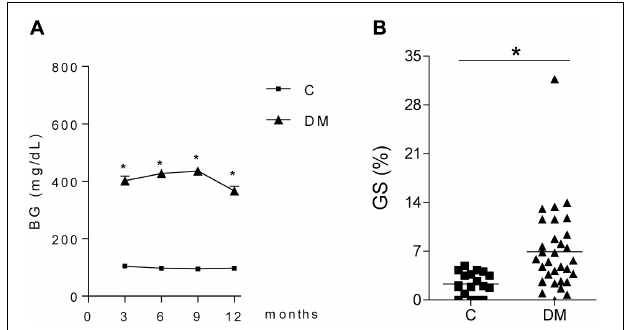
FIGURE 1 | Time course of (A) blood glucose concentration (BG, mg/dL) in diabetic (DM, n = 32) and control (C, n = 29) rats. (B) shows the frequency of glomeruli with sclerotic lesions (GS,%) in C and DM at 12 months. Results expressed as means ± SE. * p < 0.05 vs. C.